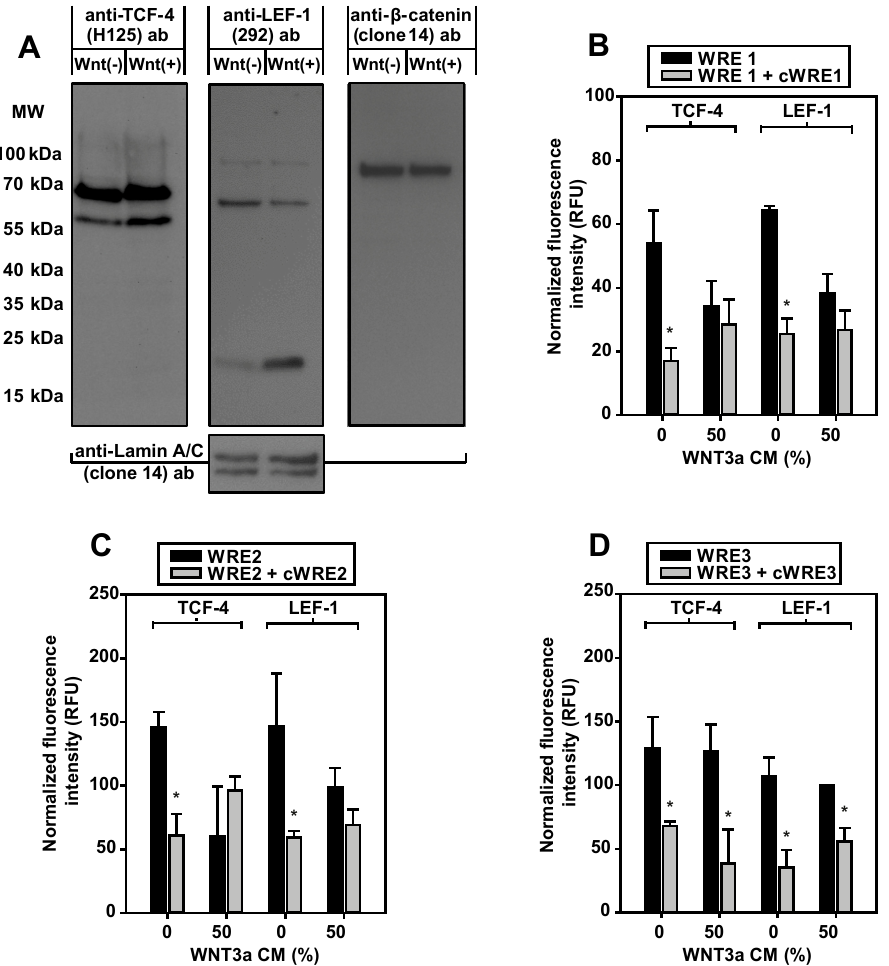
Figure 4. Expression and in vitro WRE-binding of Wnt signaling proteins. ( A ) 3T3-L1 preadipocytes were incubated overnight in serum-free medium with 10 µ M forskolin in the absence (Wnt( − )) or in the presence of 50% WNT3a CM (Wnt(+)). For Western blotting, every lane contained 100 µ g soluble nuclear extract. Membranes were (re)probed from left to right with the antibodies (ab) indicated. Comparable protein loading was tested by anti-Lamin A/C antibody. MW, molecular weight. One of two experiments is shown. ( B – D ) For each condition, 50 µ g soluble nuclear extracts from 3T3-L1 cells were subjected to immunoprecipitation, with either anti-T-cell factor-4 (TCF-4) (L40C3) or anti- lymphoid enhancer factor-1 (LEF-1) (2D12) antibody. The precipitates were incubated with WRE-specific fluorescent double-stranded oligonucleotides (WRE1, WRE2, WRE3). Binding of labeled WRE-oligonucleotides was suppressed by an excess of the corresponding nonfluorescent competitor oligonucleotide (cWRE1, cWRE2, cWRE3). Immunoprecipitates from WNT3a-stimulated cells showed no specific binding to WRE1 or WRE2. Means ± SE; n = 3; Student’s t -test (*, p <